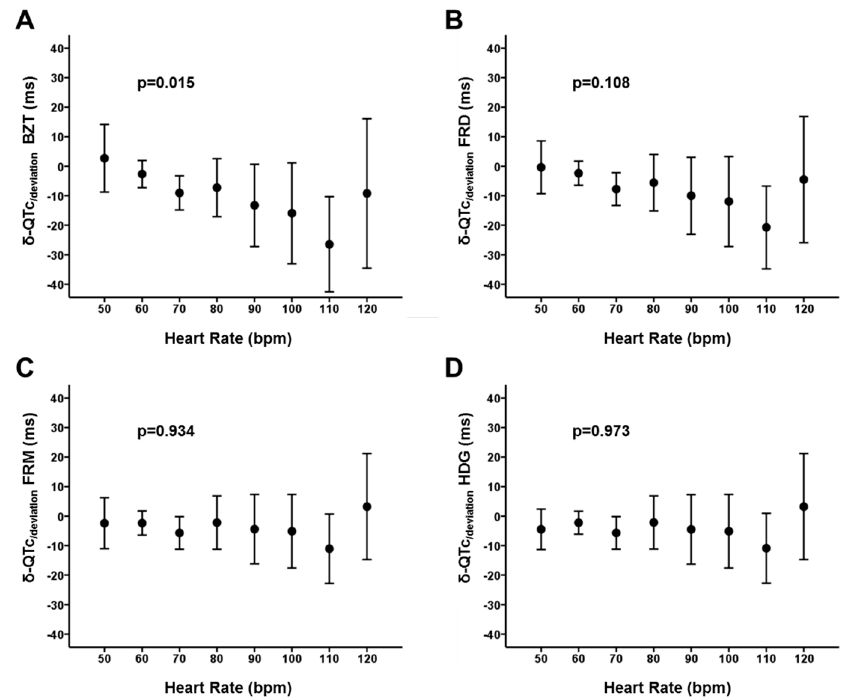
Figure 8. Heart rate dependence of the δ -QTc / deviation . See text for discussion. BZT: Bazett formula. FRD: Fridericia formula. FRM: Framinghan. HDG: Hodges formula.